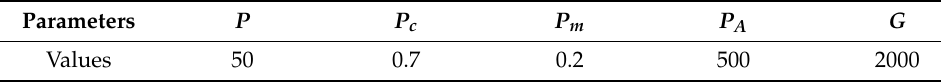
Table 3. Parameters of the INSGA-II algorithm.